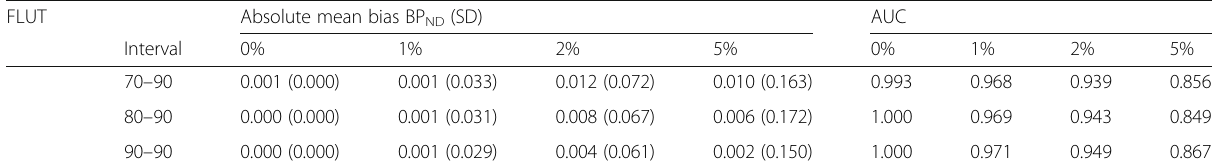
Table 5 Absolute bias in BP ND and AUC as a result of noise and the dual-time-window protocol for